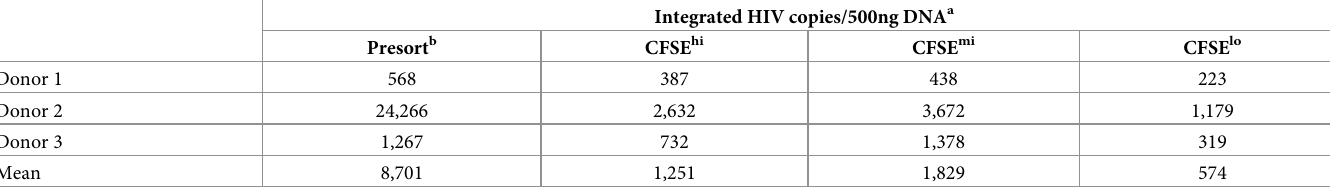
Results derived from experiments that used design outlined in Fig 4A. Sorted cell subsets recovered from end of culture on day 14. Data obtained from three independent experiments, using cells from different donors.